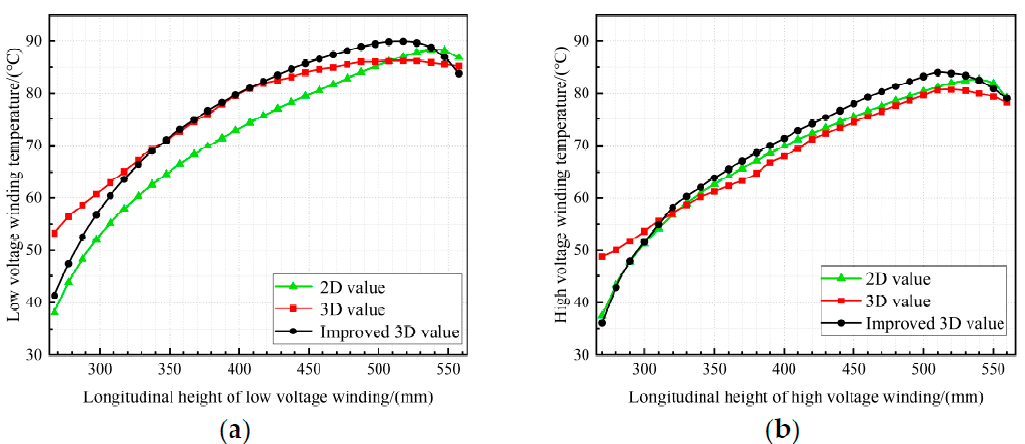
Figure 5. Simulated values on winding temperature; ( a ) Longitudinal temperature rise curve of low voltage winding, ( b ) Longitudinal temperature rise curve of high voltage winding.